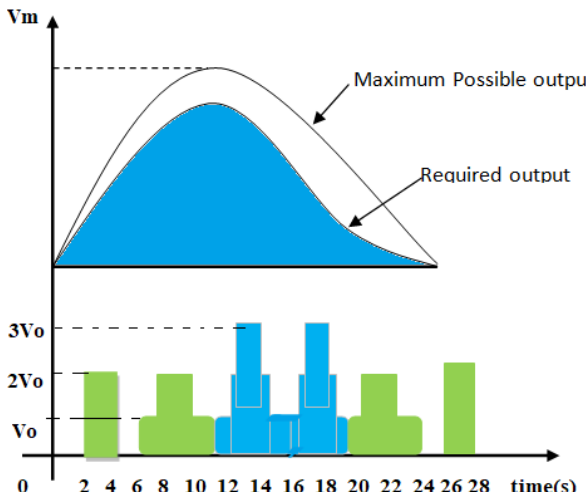
Figure 47. Basic schematic showing Area Integration Pulse Width Modulation (AIPWM) technique.